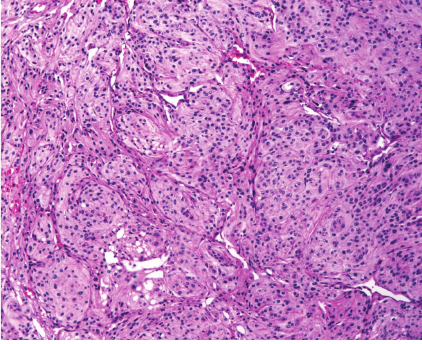
Figure 2: Photomicrograph (H& E, 10x) showing lobular arrange- ment of meningothelial cells with syncytial distribution at the periphery suggestive of meningothelial meningioma.